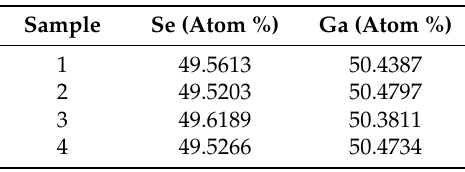
Table 1. The composition of GaSe measured by EPMA.